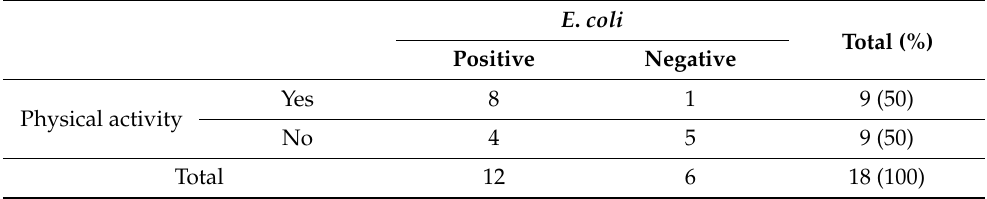
Table 4. Relationship between the presence of E . coli and physical activity in adolescents.